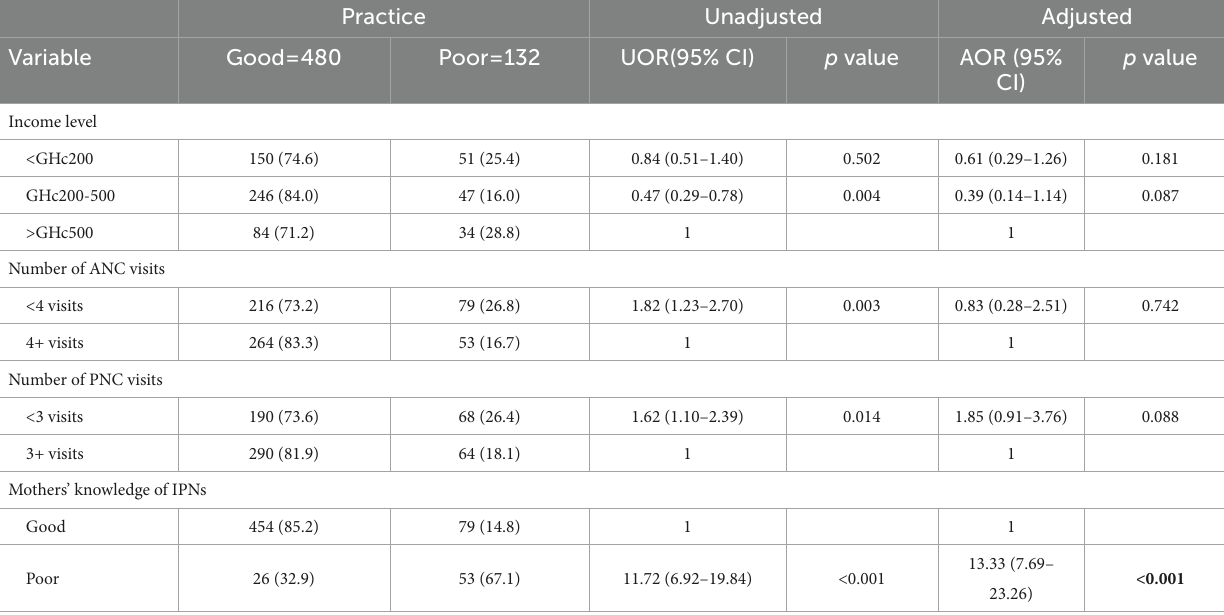
TABLE 6 Factors associated with practices of infection prevention in